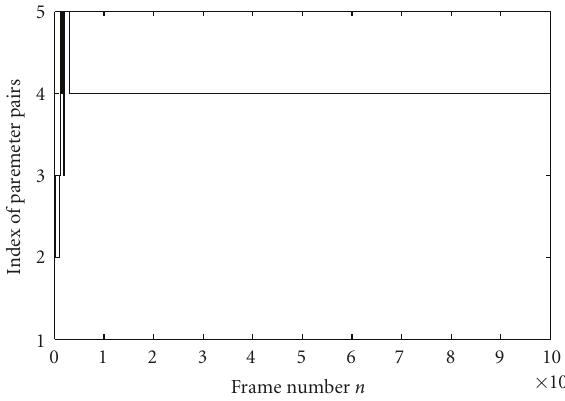
Figure 5: Parameter pair estimation in the fixed finite set.